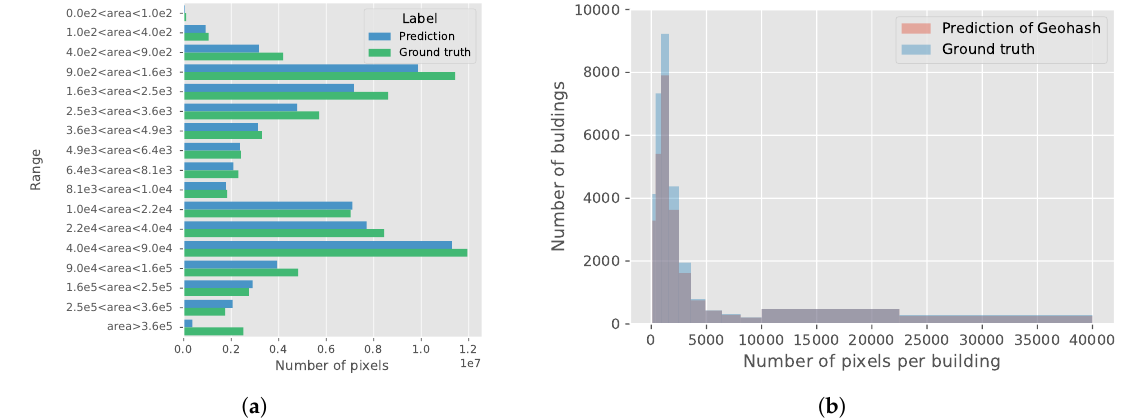
Figure 10. Comparison of the model predictions and the ground truth on the validation set of the Inria building dataset: ( a ) the area of the building size is used as the indicator for comparison; ( b ) the number of buildings is used as the indicator for comparison. From the figures, it can be clearly seen that small buildings fail to be correctly classified in terms of area and number of buildings. It should be noted that the intervals of building size in both figures are not divided